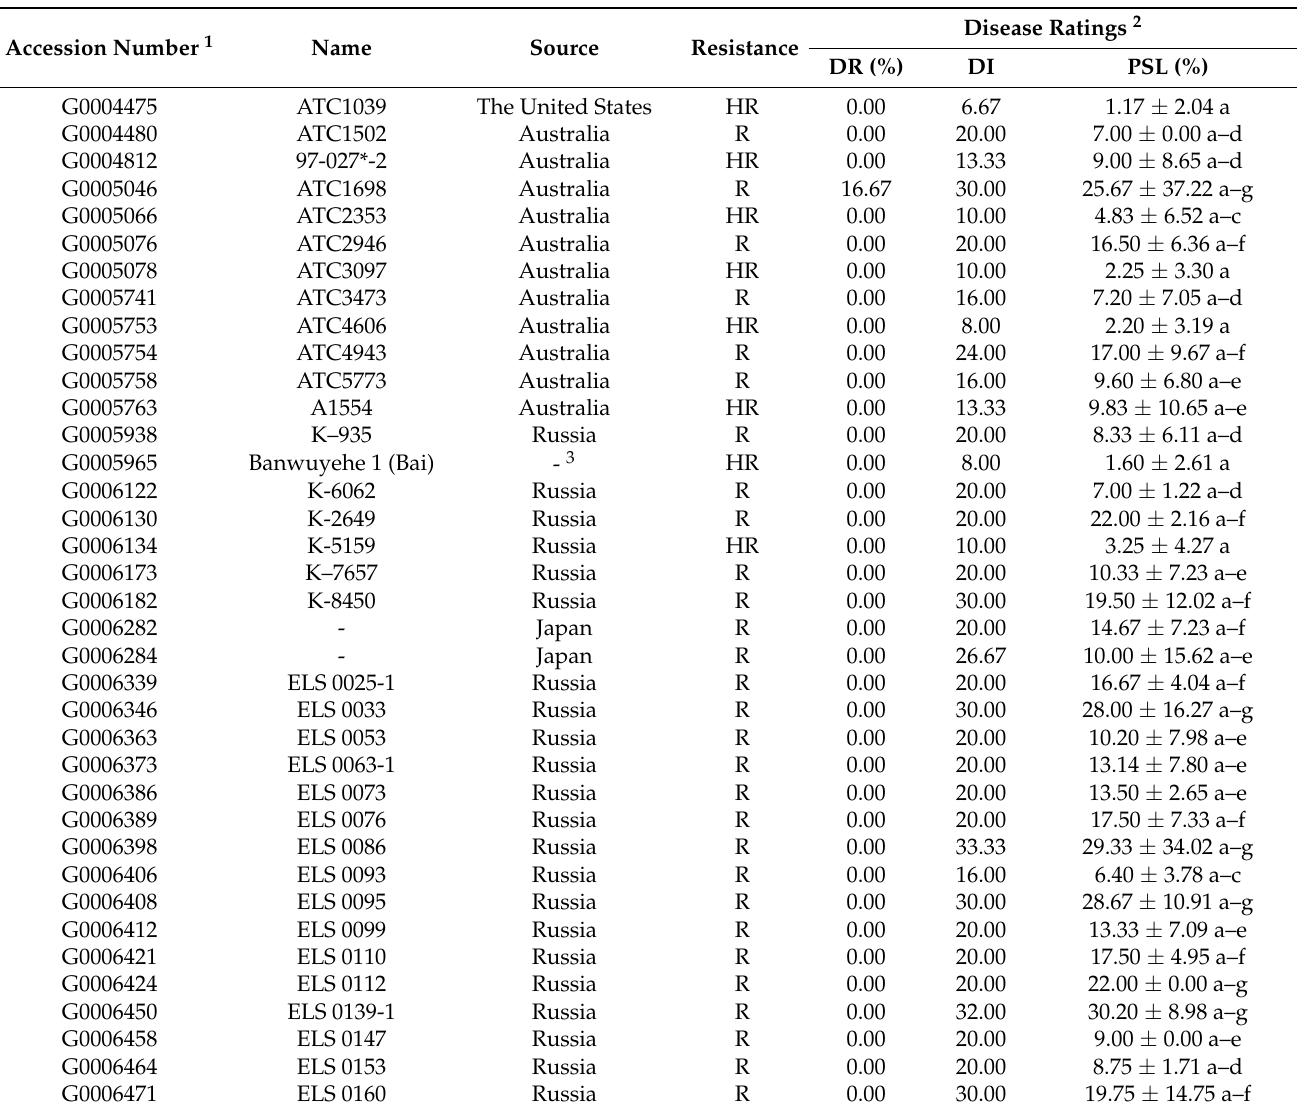
Table 4. Disease ratings of pea resistant accessions outside China and unknown sources to Fusarium oxysporum f. sp. pisi race